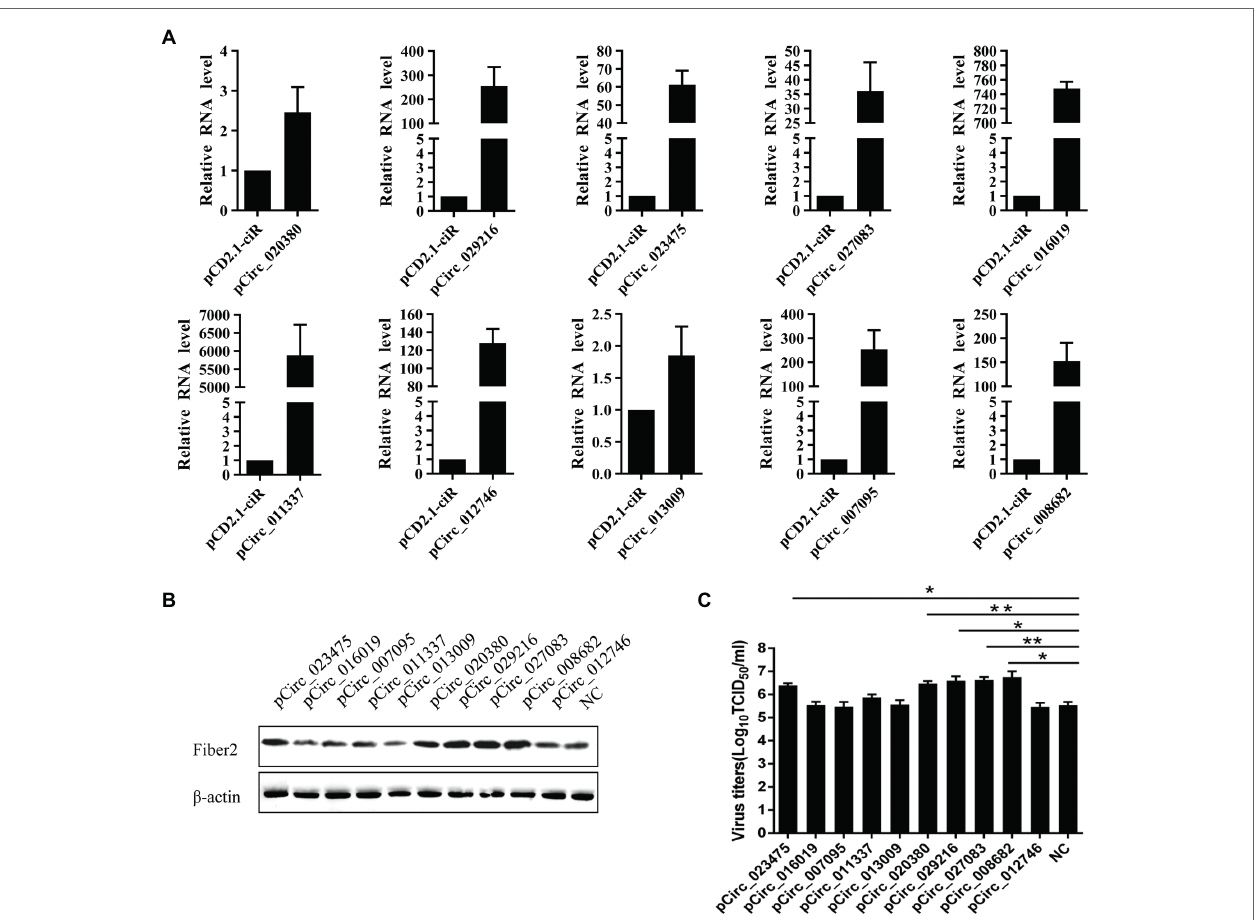
FIGURE 10 | LMH cells were transfected with empty pCD2.1-ciR plasmid or overexpression plasmid, and infected with FAdV-4 at 24 hpt. (A) The mRNA level of circRNAs was detected at 36 hpi by RT-qPCR. GAPDH was used as the reference gene. (B) The expression level of FAdV-4 Fiber 2 protein was examined at 36 hpi by western blot. β -actin was used as the reference gene. (C) Virus titers in supernatants were measured at 36 hpi. All data are presented as the means ± SD of three independent experiments. * p < 0.05 and ** p <